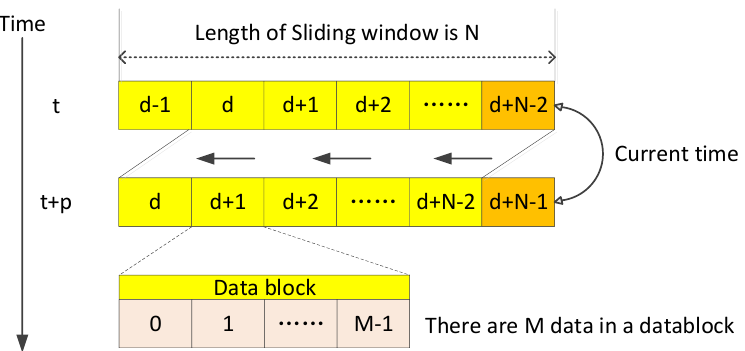
Figure 6. Sliding Window of the sink